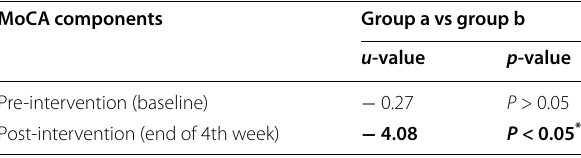
*Significant p -value ( p